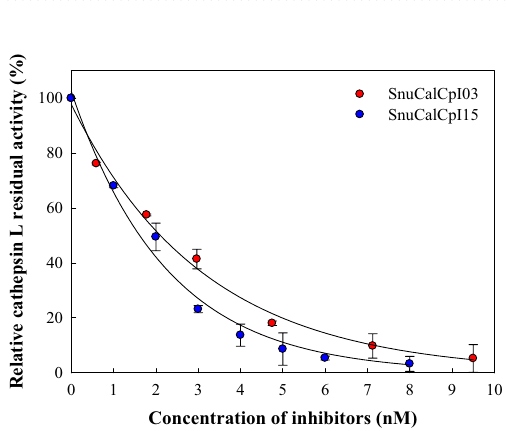
Figure 1. Inhibitory activity of SnuCalCpIs against papain.